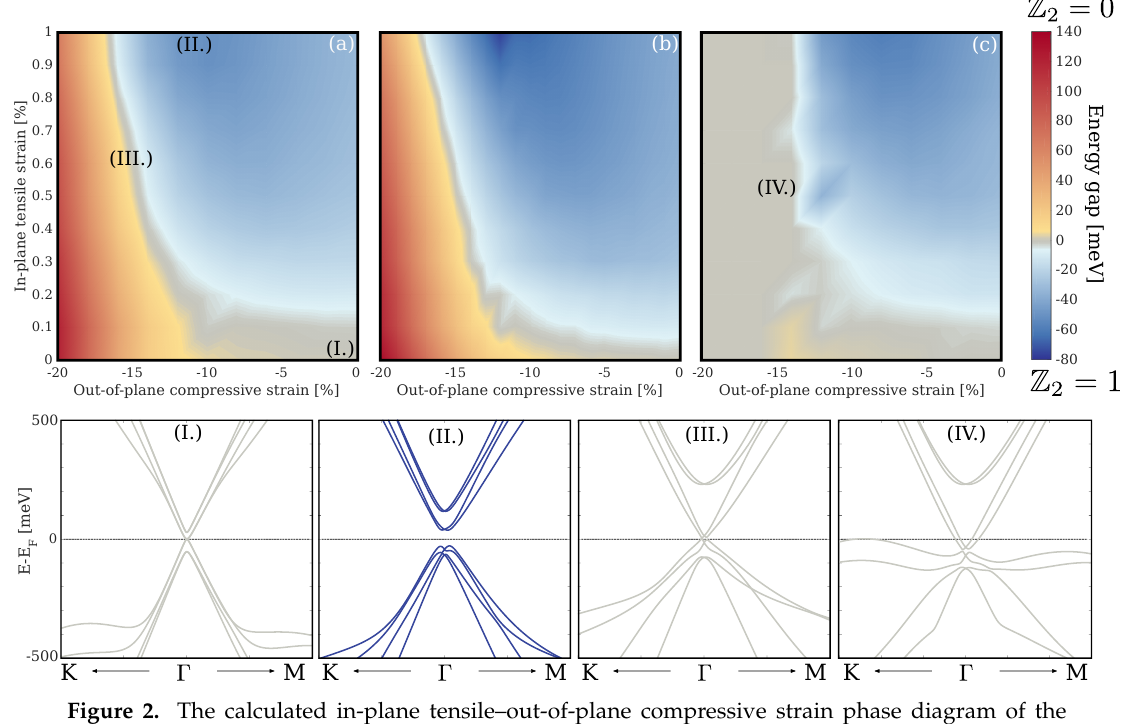
Figure 2. The calculated in-plane tensile–out-of-plane compressive strain phase diagram of the BiTeCl/BiTeBr/BiTeI–graphene structures ( a – c ) respectively. The blue colors indicate that the gap is topological, while the red hue means that is trivial. The metallic shade marks the phase boundary. Subfigures (I.)–(IV.) are the corresponding band structures of the marked phases near the Γ point in momentum space (color